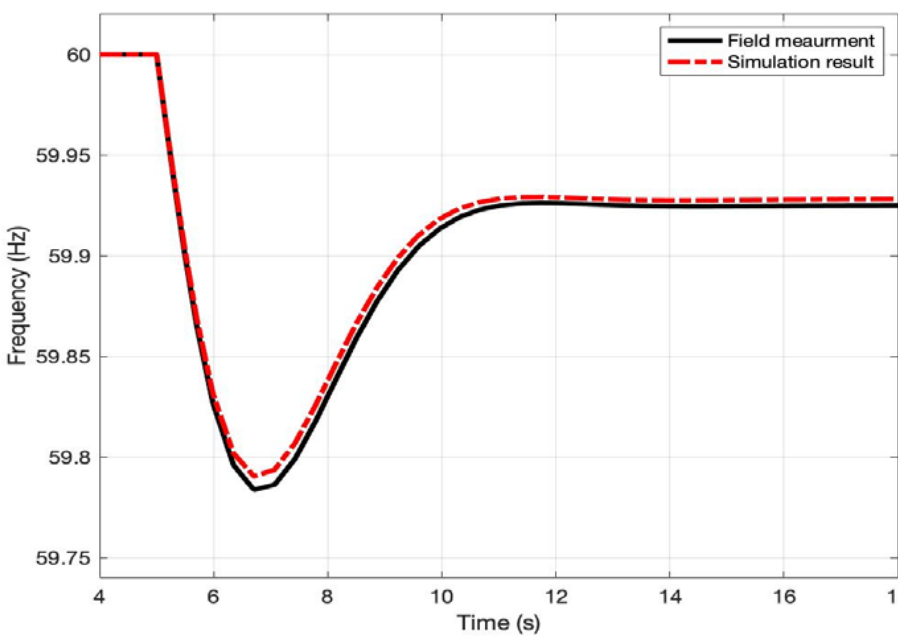
Figure 7. Frequency response following a power loss of 1206